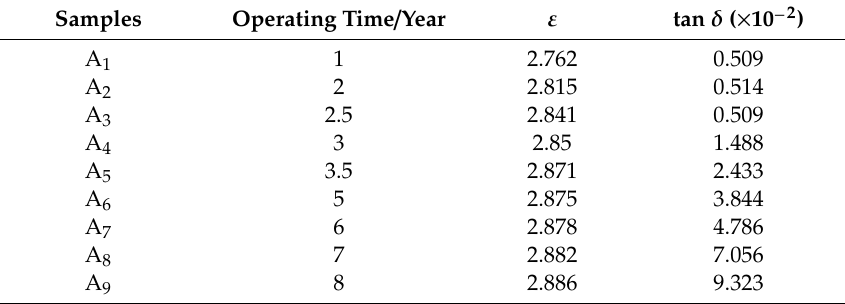
Figure 3. Dielectric parameters of samples of different ages: ( a ) complex dielectric permittivity ε ; ( b ) dielectric loss tan δ . Table 4. Dielectric parameter of samples in different years at frequency of 0.1 Hz.